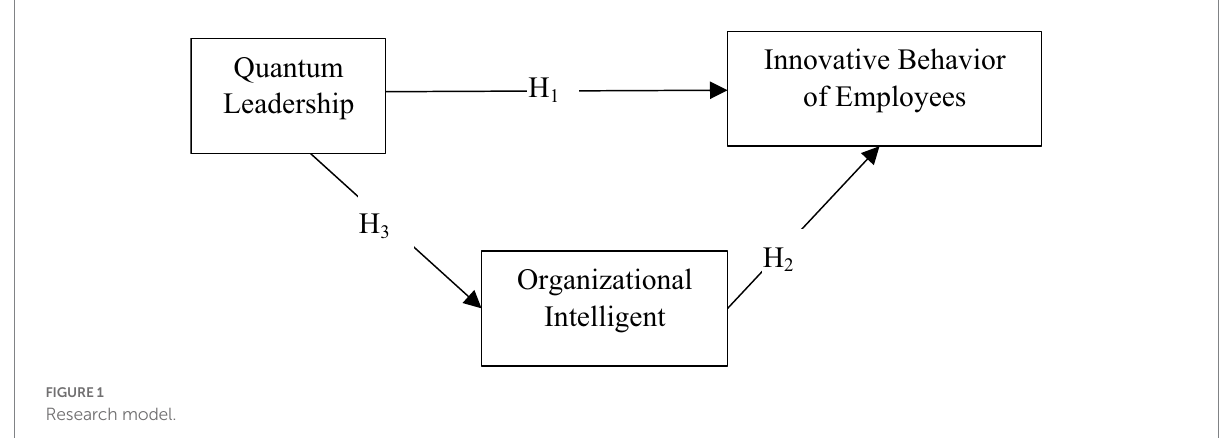
FIGURE 1 Research